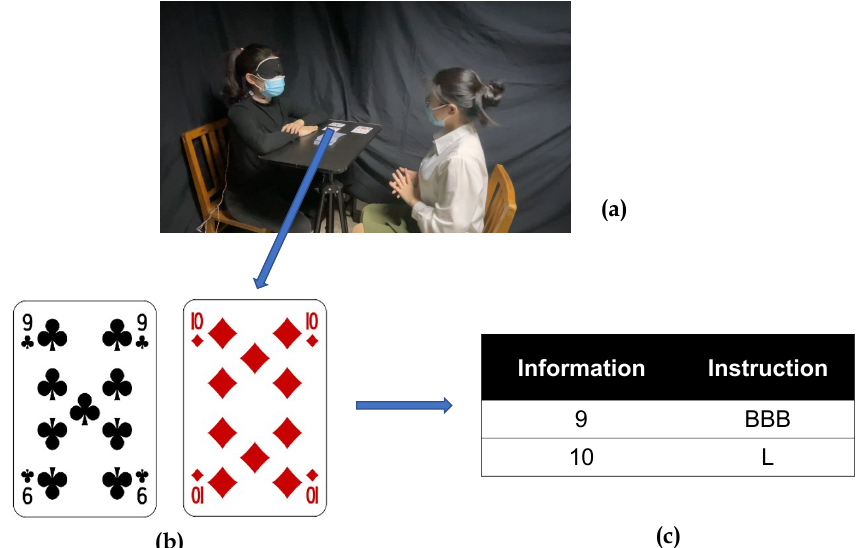
Figure 6. Coding Scenario Application. ( a ) Subjects on the left are patients with visual disabilities, and subjects on the right are normal subjects. Instructions are transmitted through the background. ( b ) The specific card face of the visually impaired subject. ( c ) The corresponding transmission command of the card face.